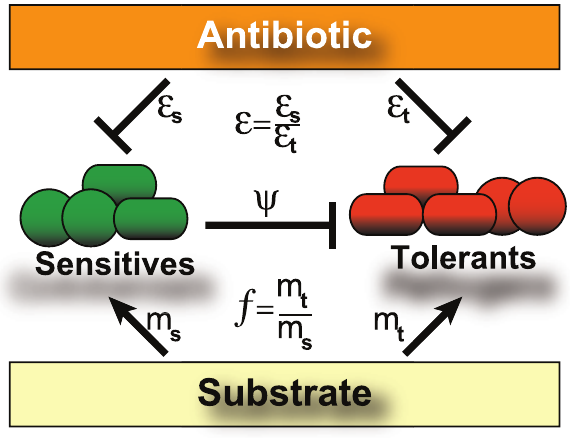
Figure 1. The two-group model of the intestinal microbiota with antibiotic-sensitive and antibiotic-tolerant bacteria. Anti- biotic sensitives can inhibit the growth of tolerants and both groups compete for the same growth substrate. Model parameters E s and E t represent the antibiotic sensitivity of sensitive and tolerant bacteria (where E s v E t ), m s and m t represent their affinities to substrate and y represents the inhibition of tolerants by sensitives.